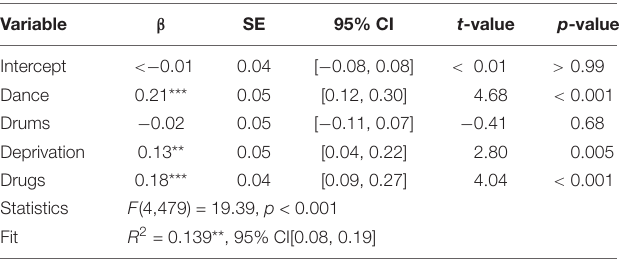
TABLE 3 | Model for Hypothesis 1c: Predicting awe with the 4Ds